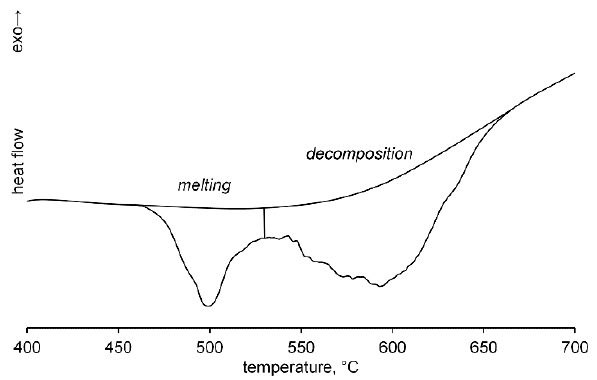
Figure 4. FSC curve for γ -cyclodextrin at heating rate of 10,000 K s −1 .